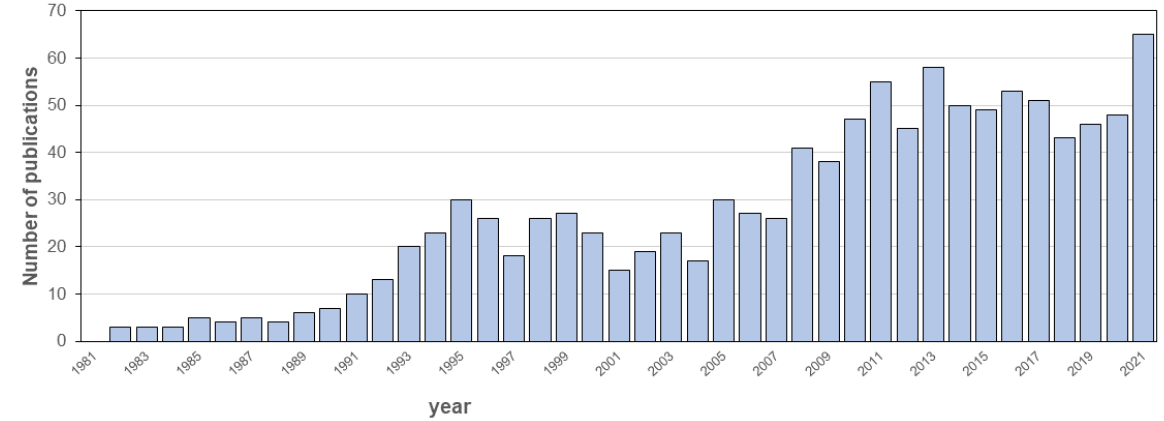
Figure 1. Publications on targeted colonic release in 1981 – 2021. Source